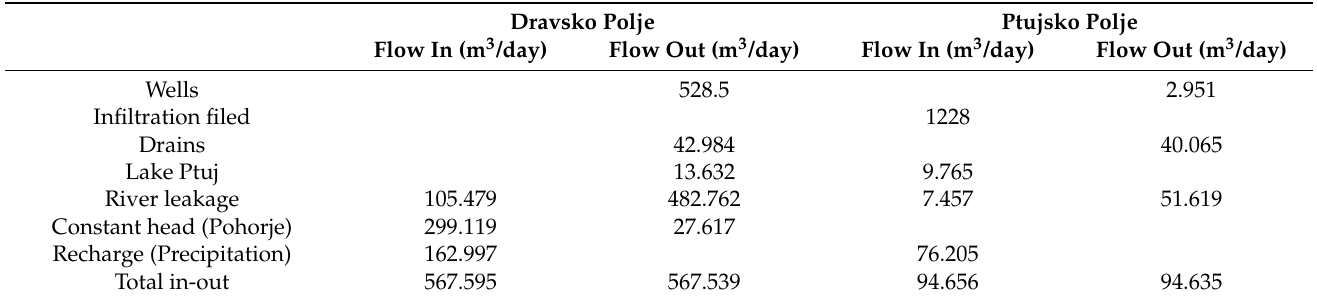
Table 5. Model flow budget results for the Dravsko polje and Ptujsko polje aquifers. Dravsko Polje Ptujsko Polje Flow In (m 3 /day) Flow Out (m 3 /day) Flow In (m 3 /day)